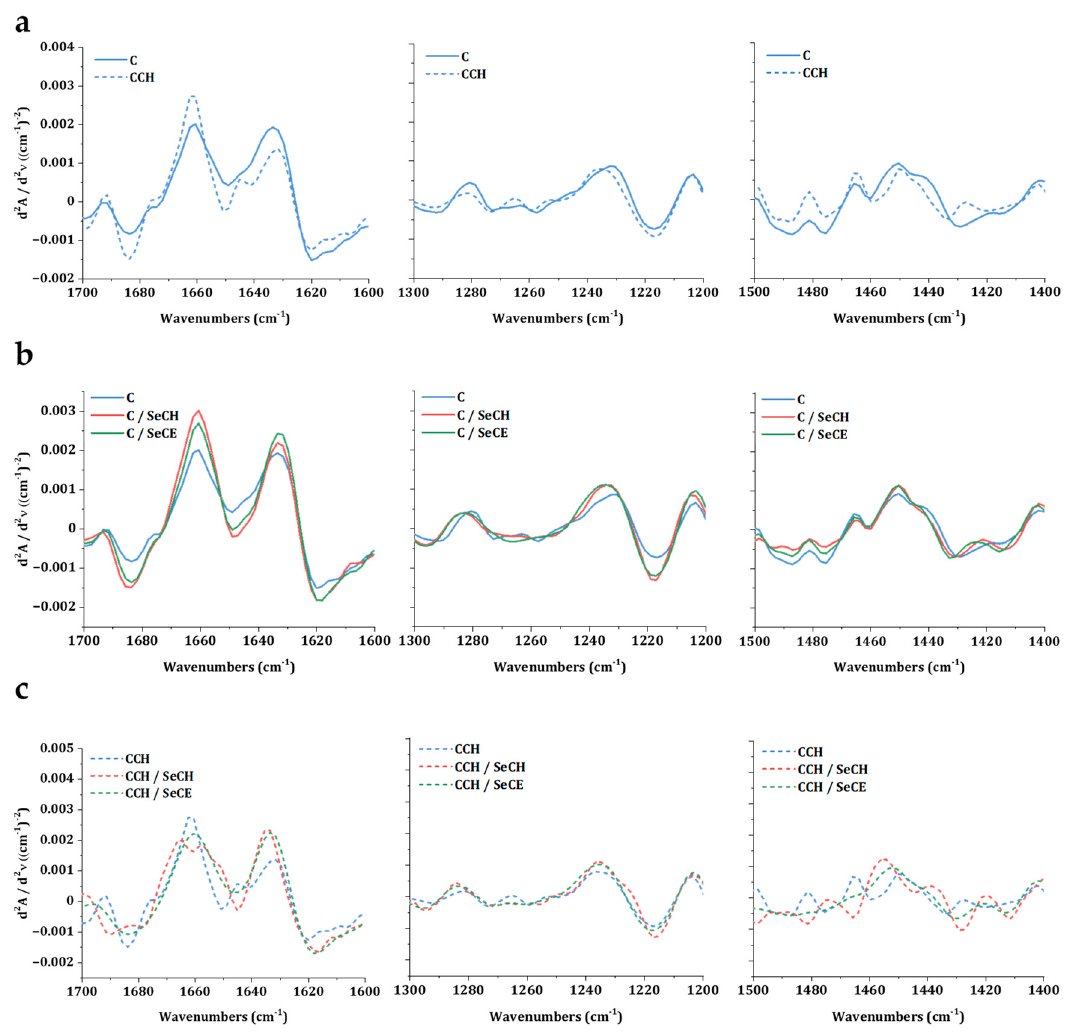
Figure 5. Second derivative spectra of C and CCH scaffolds ( a ), C-based scaffolds with SeNPs ( b ), and CCH-based scaffolds with SeNPs ( c ) exhibiting the Amide I region (1 st column), Amide III region (2 nd column), and the region of pyrrolidines (3rd column).